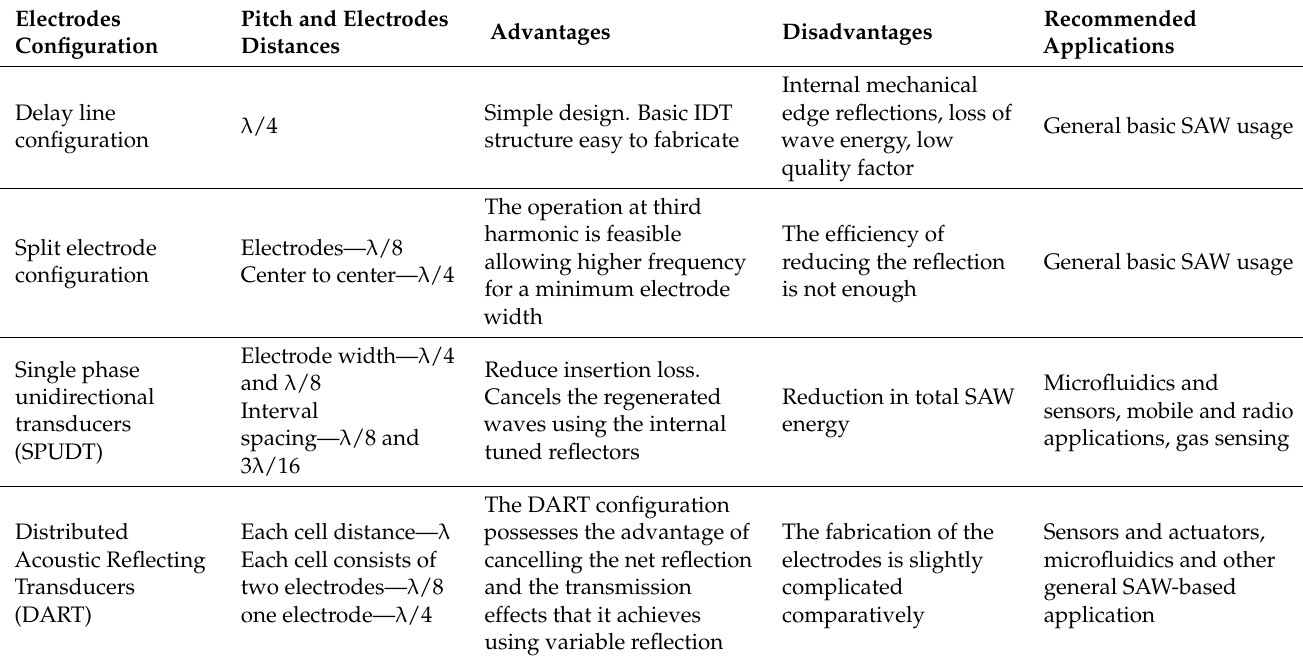
Table 5. Comparison and recommendations of the IDT types for SAW applications.